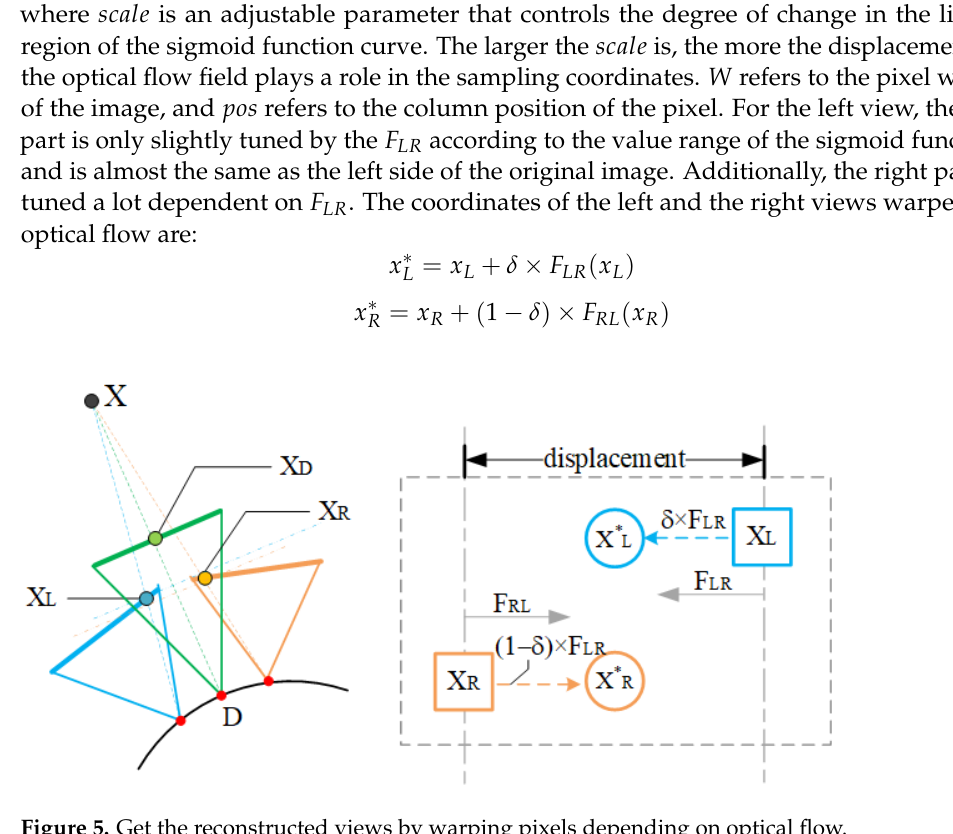
Figure 5. Get the reconstructed views by warping pixels depending on optical flow. Figure 6 shows the left and the right views after optical flow adjustment. The top and the bottom of the first column are the original left and right views, and the second column is the value map of the adjustment function according to amplitude adjustment parameter. The brighter part indicates that the original view is adjusted a lot by the optical flow. The third column is the reconstructed left and right viewpoint images, depicting that the vertical distortion with red line is corrected after the optical flow adjustment. The last column is the synthesized view.